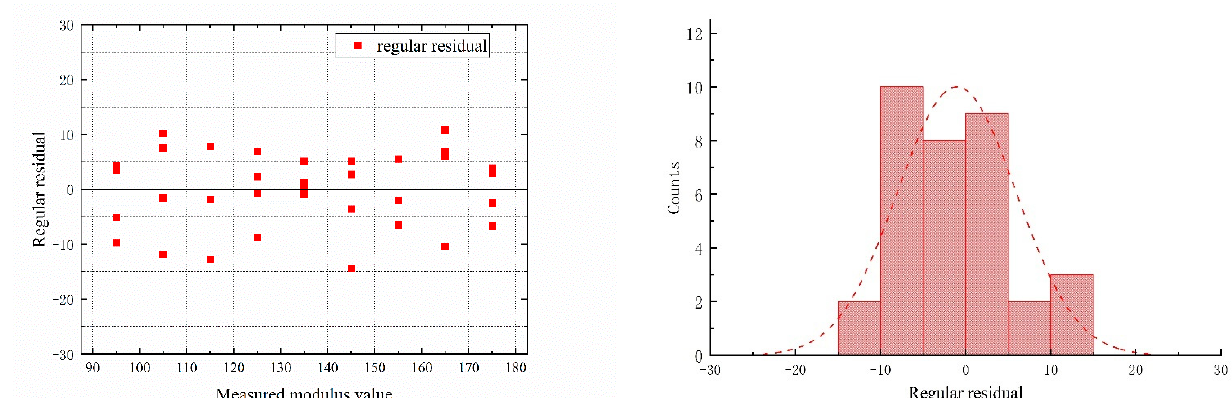
Figure 3. Residual distribution diagram.